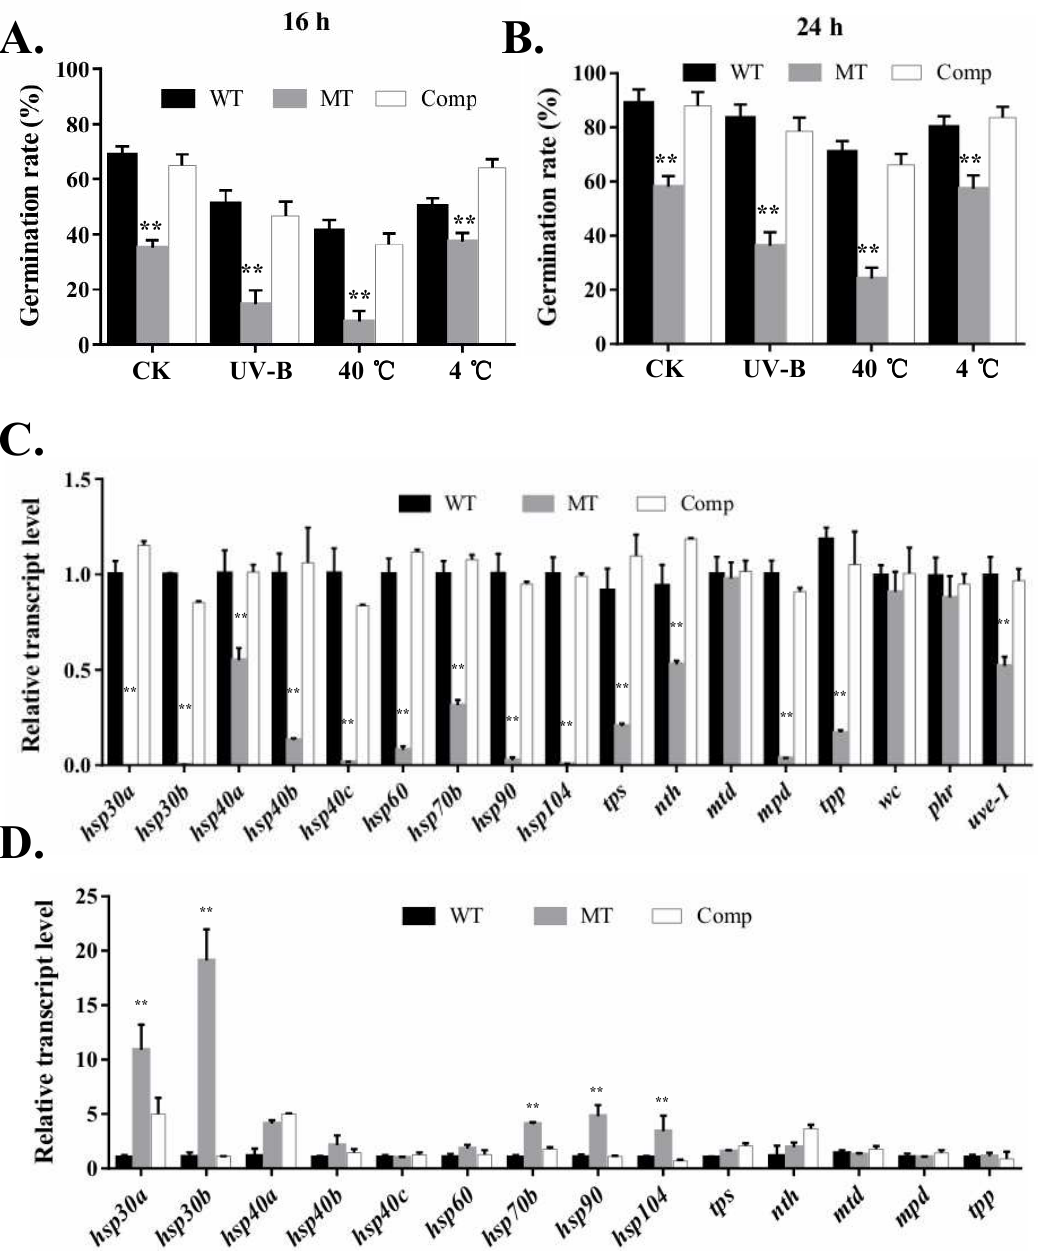
Figure 4. Spore survival assays of di ff erent M. robertsii strains following UV-B, heat and low temperature treatment. Germination rate of conidia from the 3 strains at 16 h (A) and 24 h (B) after UV-B, heat and low temperature exposure. Conidia of the 3 strains (WT, ∆ MrUBI4 , and Comp) were either UV-B irradiated at 100 µ J · cm − 2 or heated at 40 ◦ C (and low temperature at 4 ◦ C) for 90 min. Germination rates were determined after inoculation on PDA plates at 25 ◦ C for 16 and 24 h. (C) Relative expression analysis of heat stress- and DNA damage response-related genes in conidia under thermal- and UV-treated stress. (D) Relative expression analysis of heat stress-related genes in conidia under normal conditions (25 ◦ C for cultivation). **, p < 0.01. WT: wild-type strain, MT: ∆ MrUBI4 strain, Comp: complementary